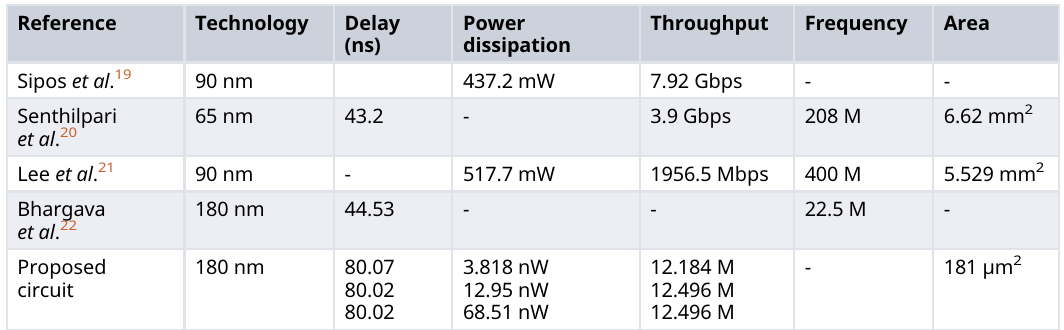
Table 4. Comparison of proposed circuit results with published